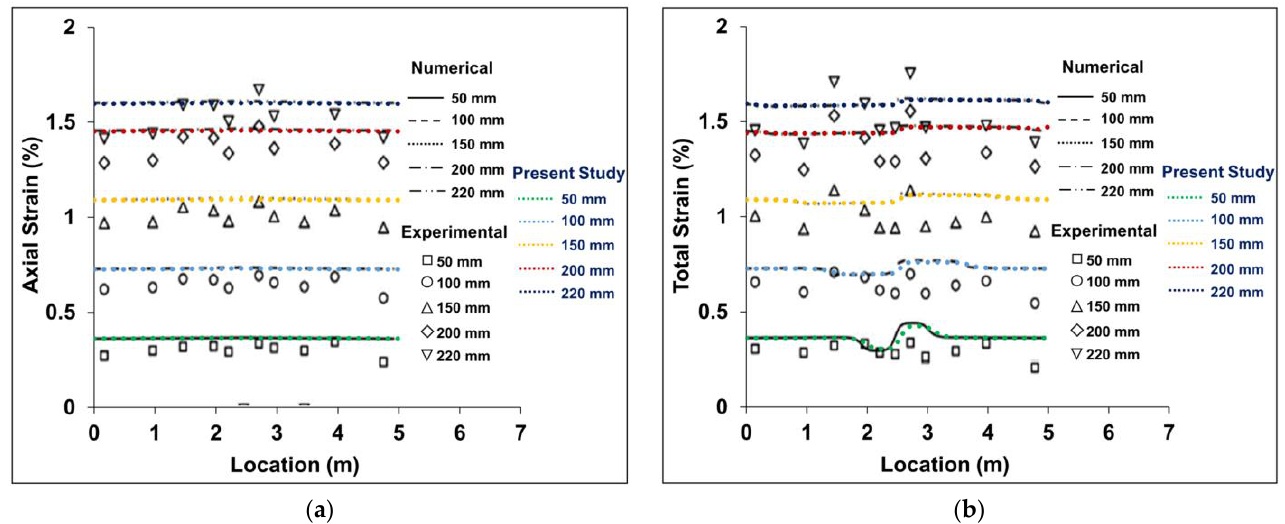
Figure 4. Comparison of the proposed FE model and the experimental and FE model of Wang et al. [32] for the response of a submarine cable to the lateral seabed movement in terms of: ( a ) axial strains and ( b ) total strains.